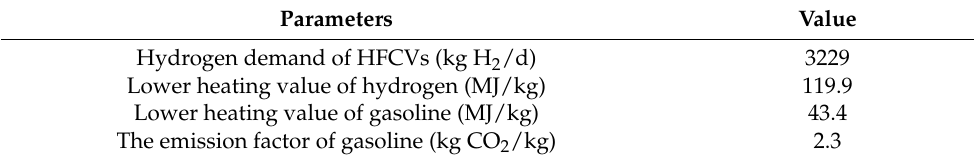
Table 13. The parameters of emission reduction of HFCVs for cases.